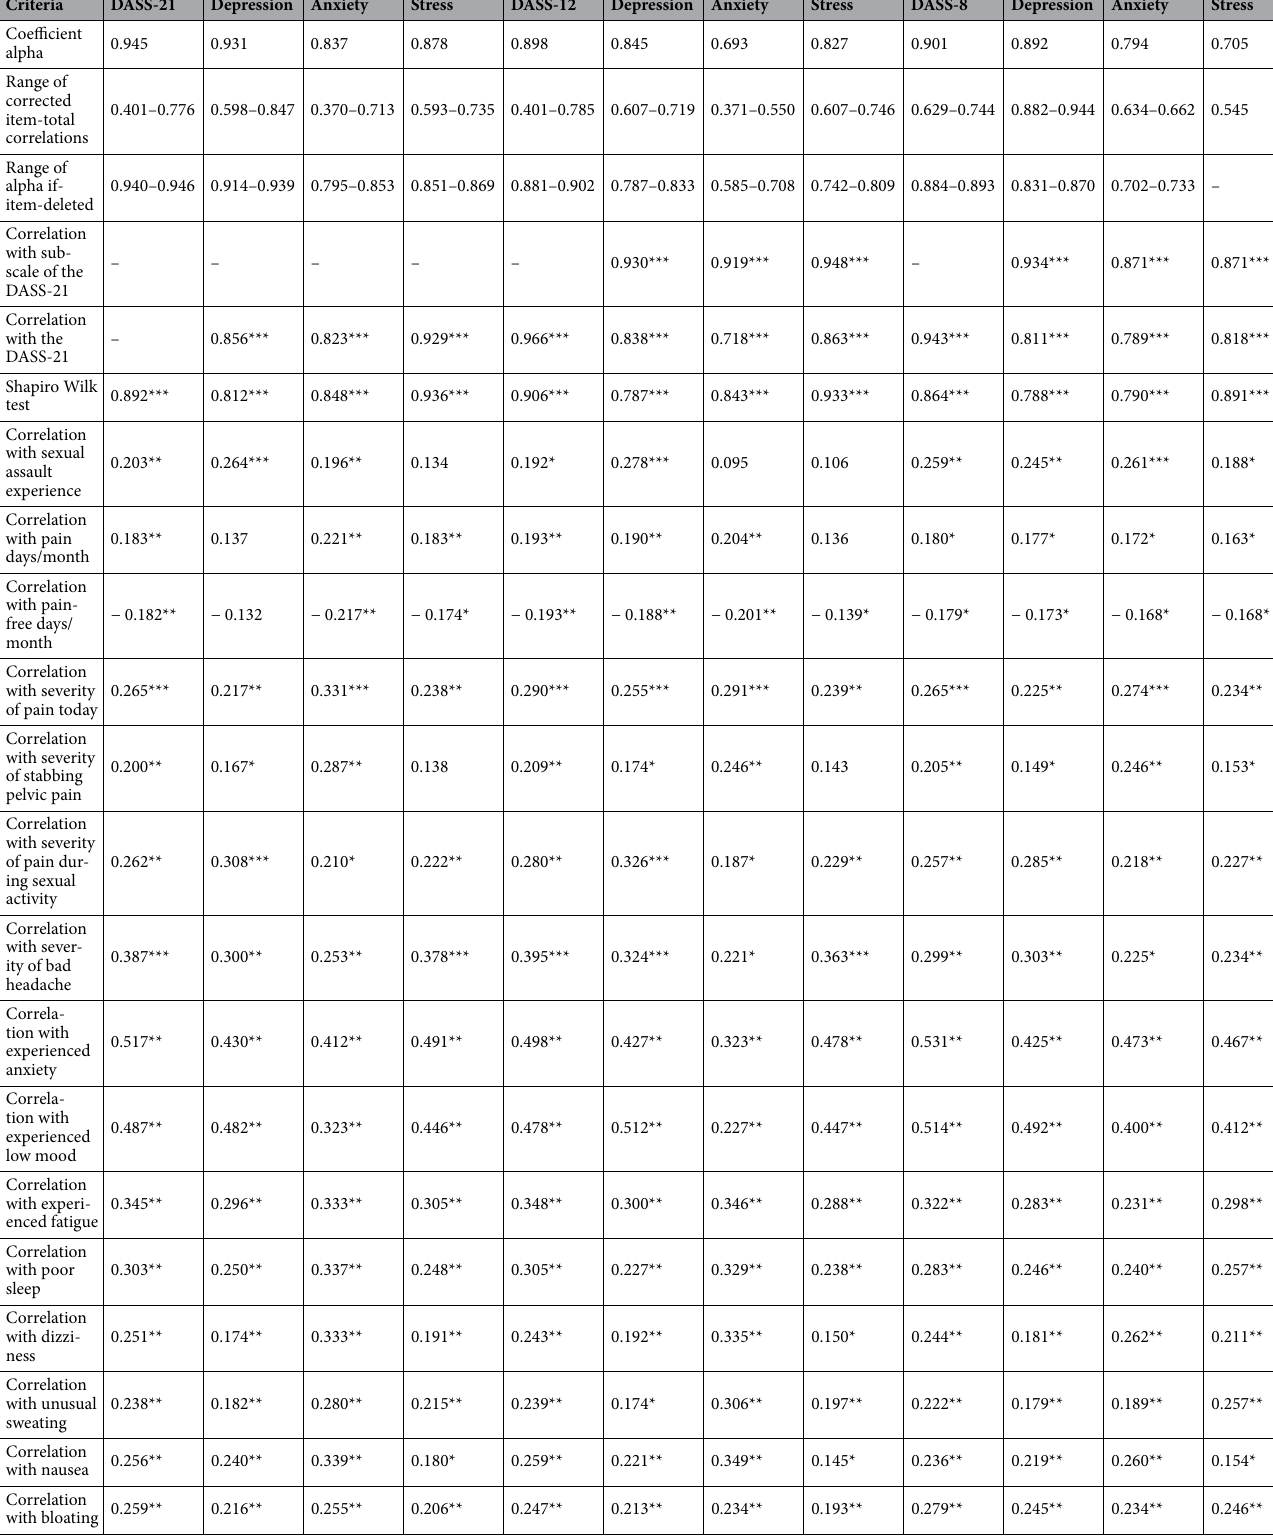
Table 5. Internal consistency, predictive validity, normality, and criterion validity of the Depression Anxiety Stress Scale (DASS) 21, DASS-12, DASS-8, and their subscales among women with chronic pelvic pain. *, **, ***: correlation is significant at a level of 0.05, 0.01, 0.001,